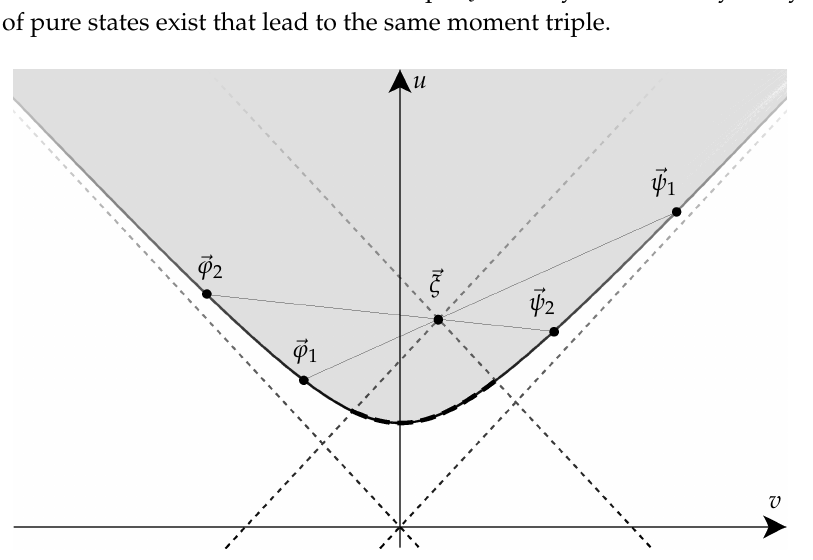
Figure 1. Cross-section ( w = 0) of the uncertainty region (shaded) illustrating the convexity of its boundary u 2 − v 2 − w 2 = ¯ h 2 / 4; convex combinations of moment triples located on the hyperboloid (associated with pure Gaussian states with minimal uncertainty) reproduce any given moment vector (cid:126) ξ inside the uncertainty region (the points must be outside of the “back-ward light-cone” of the point (cid:126) ξ , indicated by the dashed segment of the